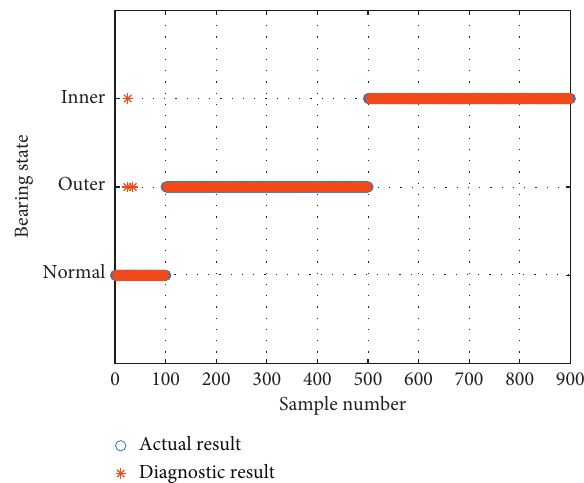
Figure 16: Fault diagnosis results of constant speed samples.